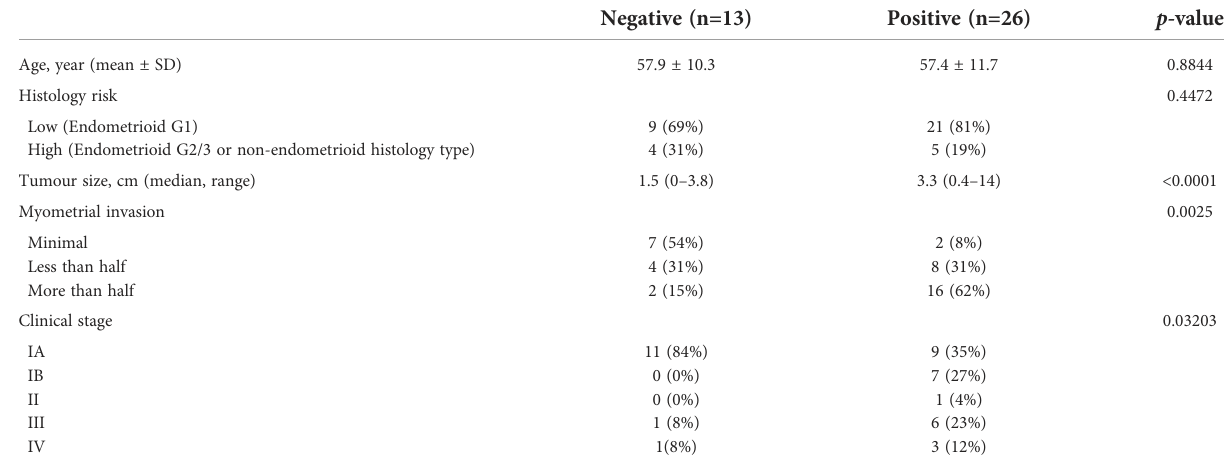
TABLE 3 Comparison of clinicopathological factors between patients who are detected verses those who are not detected by cervical swab- based genomic DNA (gDNA) among patients with endometrial cancer.